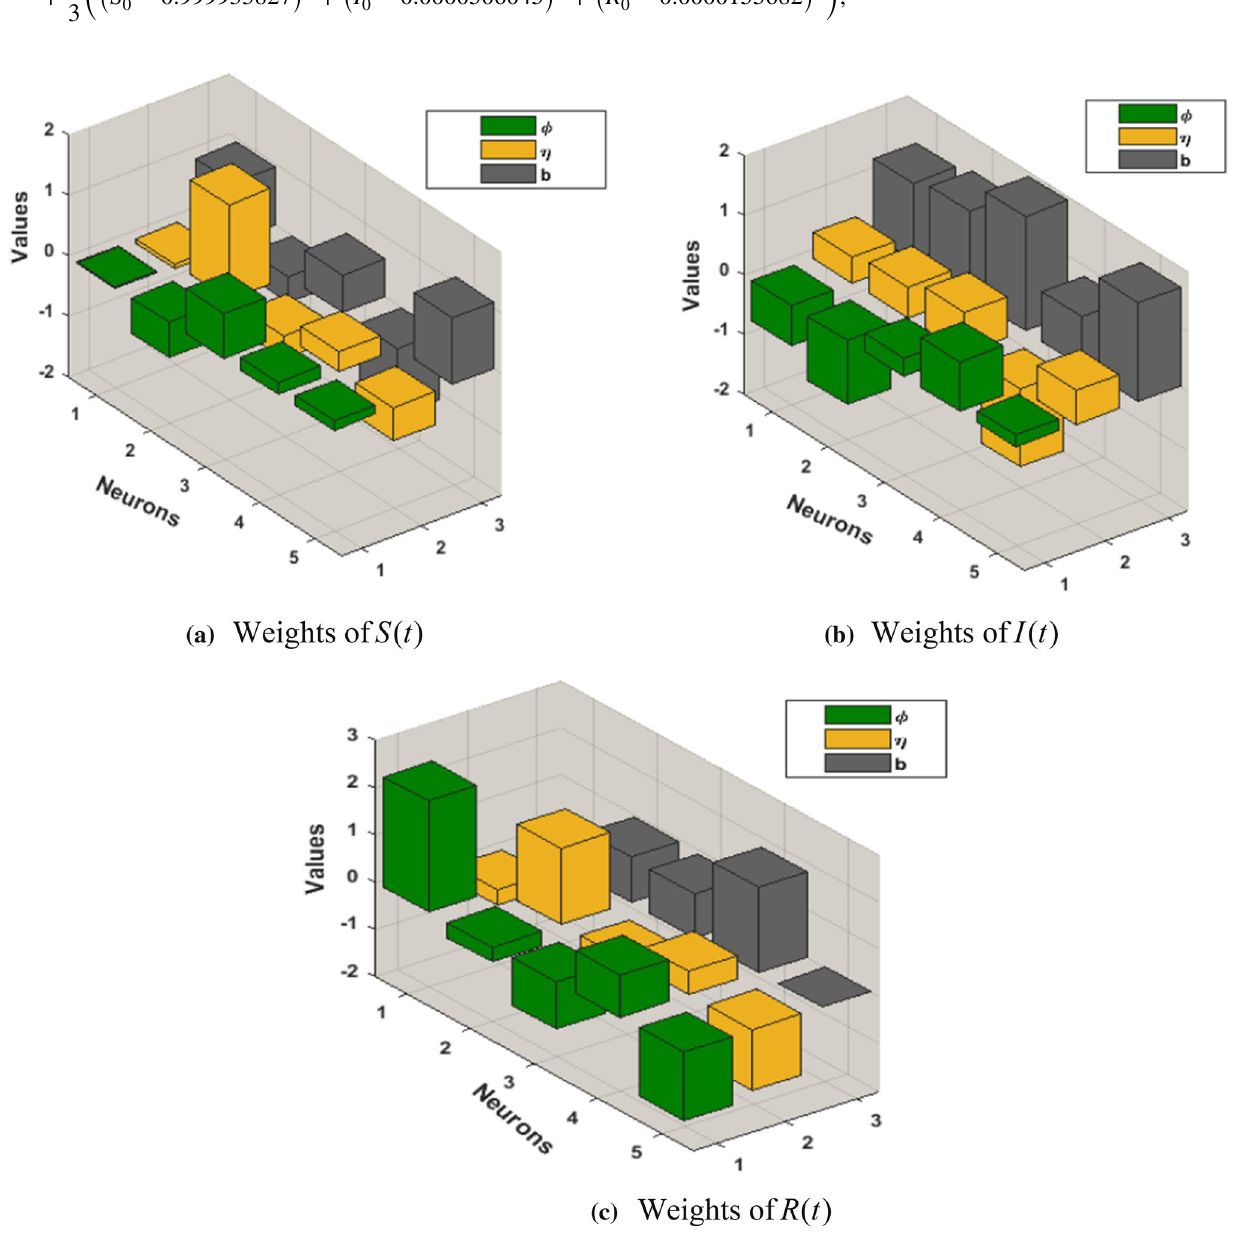
Fig. 2 Weights of ANN-GA-SQP based on the fitness for COVID-19 SIR